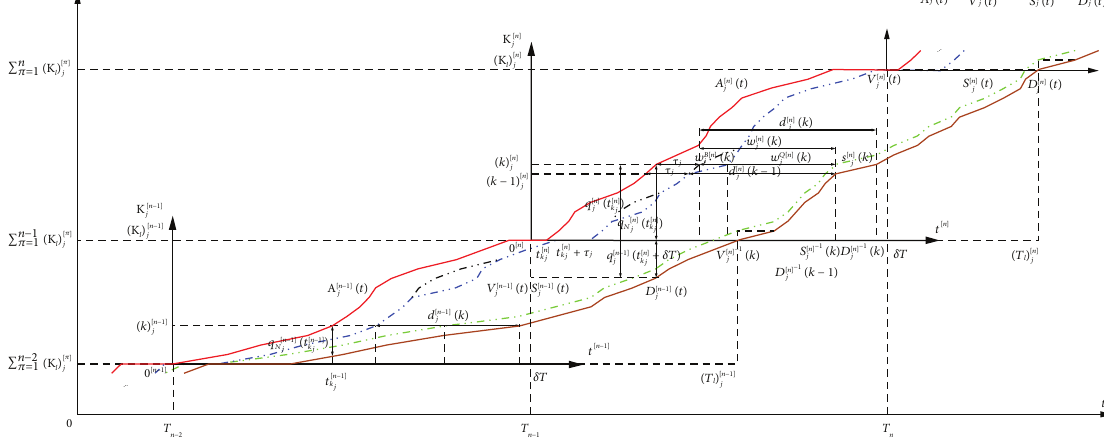
Figure 18: Profiles at a single tollbooth in the entire time horizon and divided